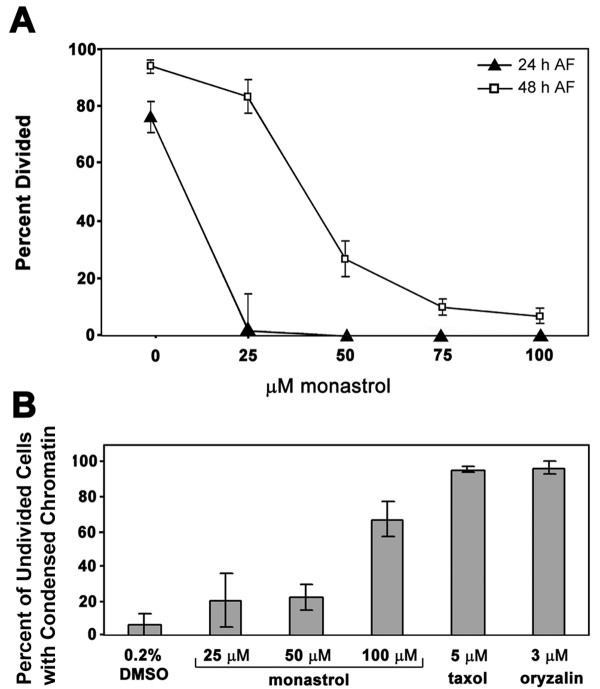
Monastrol treatment led to cell cycle delay at low concentrations and cell cycle arrest at high concentrations. (A) Filled triangles depict cell plate formation at 24 h AF, and open squares depict cell plate formation at 48 h AF. (B) Chromatin condensation in undivided cells at 48 h AF assayed by labeling with antibody to phosphorylated histone H3. Bars are standard errors.